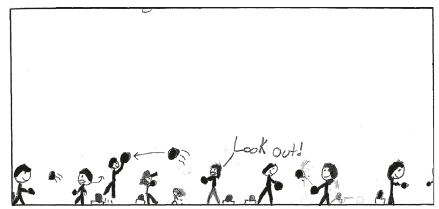
Figure 3: Photo journal drawing representing stage 3: developing